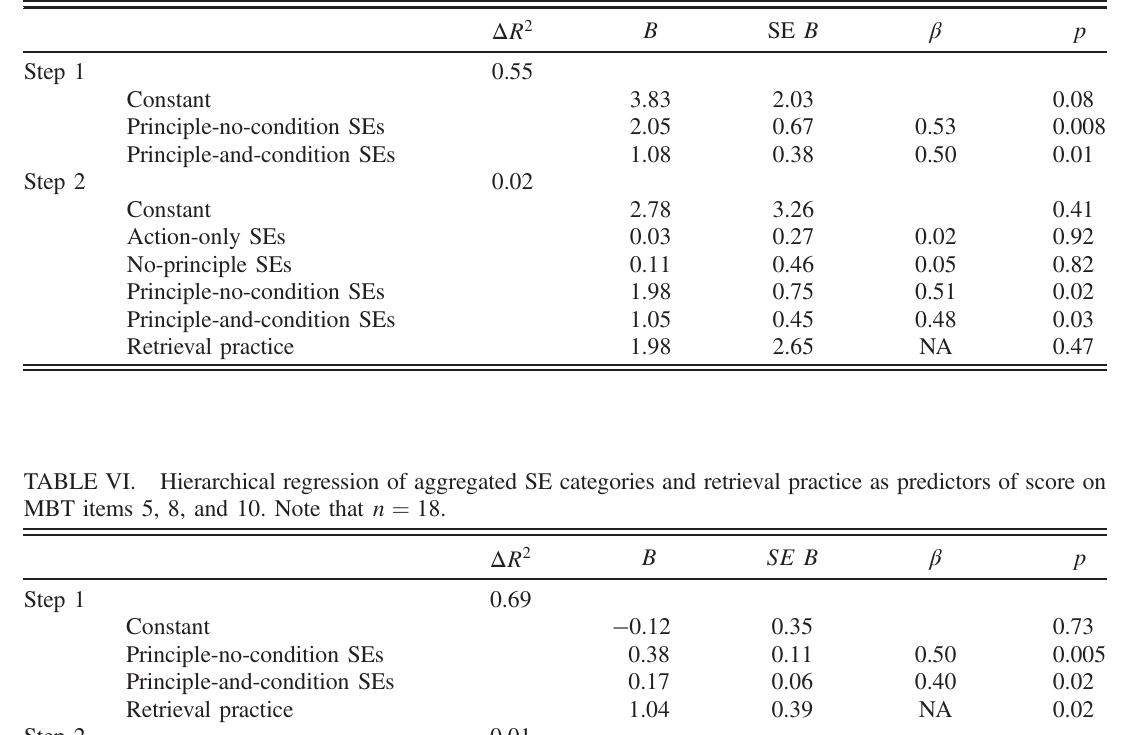
TABLE V. Hierarchical regression of aggregated SE categories and retrieval practice as predictors of post-test problem-solving score. Note that n ¼ 18 .